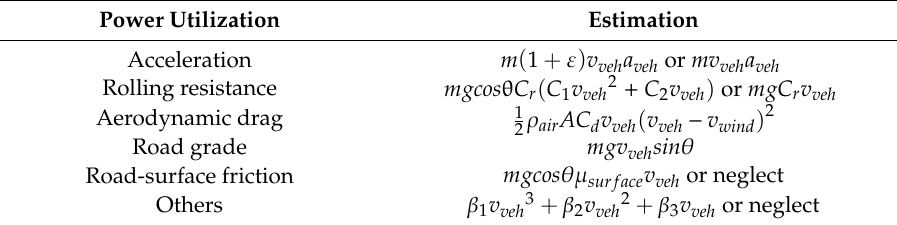
Table 1. Driving-power estimation classified by contributing factors